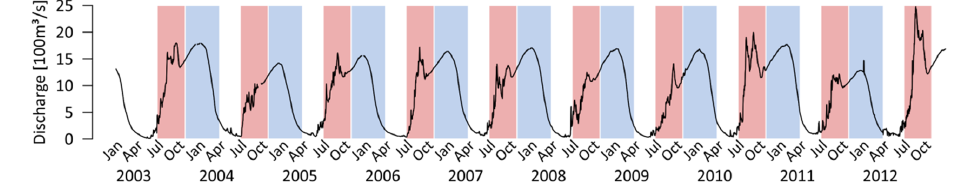
Figure 2. Hydrograph of the Niamey gauging station with Sahelian flooding (red) and Guinean flooding (blue) for the period from 2003 to 2012.